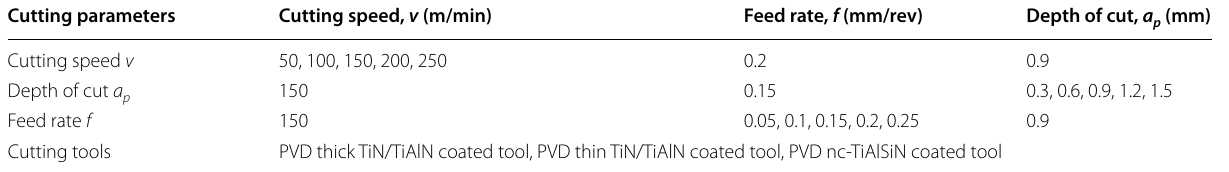
Table 3 Experimental parameters in dry turning of MCI Cutting parameters Cutting speed, v